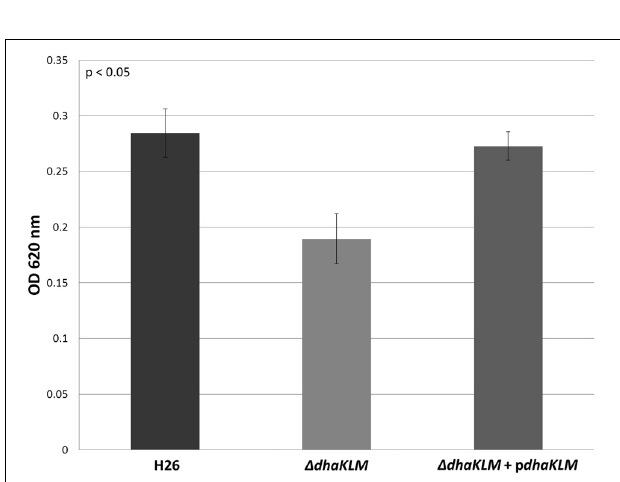
FIGURE 3 | Cell density of H26, (cid:2) dhaKLM , and (cid:2) dhaKLM + p dhaKLM at stationary phase when grown on 5mM DHA. Cell density is represented by the average optical density (OD 620 ) reading of three cell culture replicates. Error bars depict the standard deviation of the averages. ANOVA single factor, p < 0 . 05.